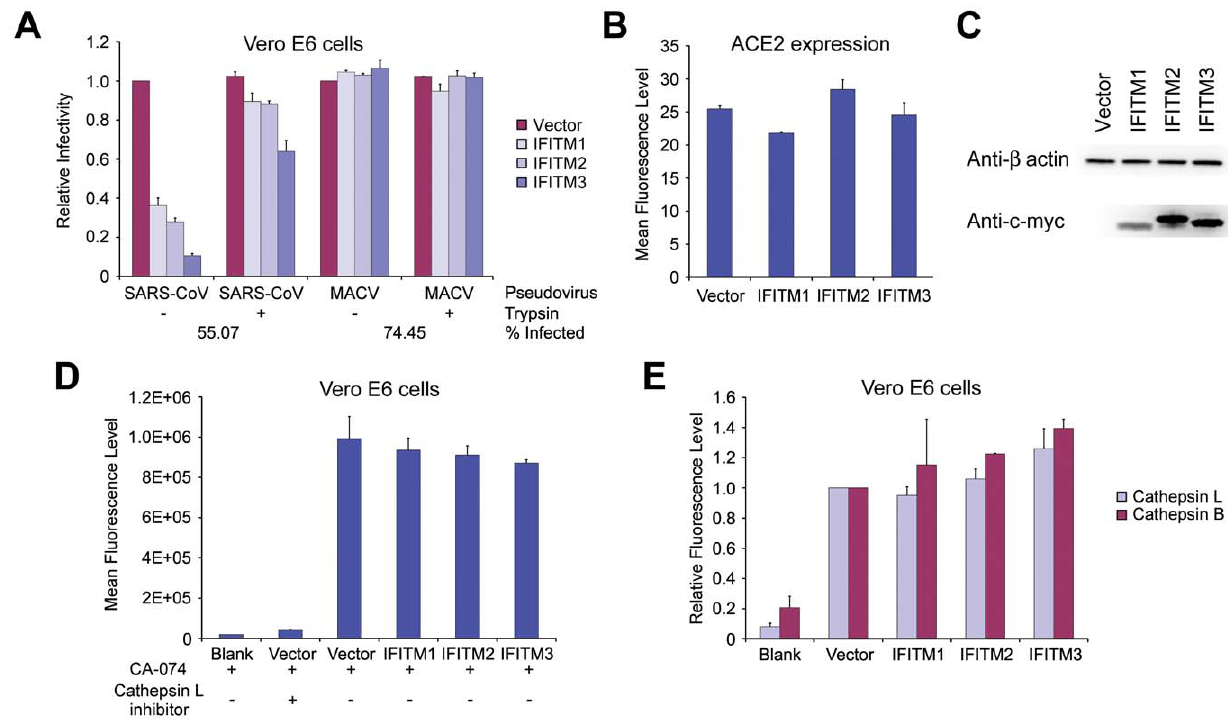
Figure 6. Trypsin treatment bypasses IFITM restriction of entry mediated by SARS-CoV S protein. ( A ) Vero E6 cells transduced to express the indicated c-myc-tagged IFITM proteins or with vector alone were subsequently transduced to express ACE2. Two days later, cells were spin- inoculated at 4 u C with indicated pseudoviruses and then treated with 5 m g/ml trypsin or phosphate-buffered saline (PBS) at 37 u C for 13 minutes. Infected cells were maintained in growth medium and pseudovirus infection was determined by flow cytometry two days later. Relative infectivity was shown as the percentage of GFP-positive cells, normalized to that of cells transduced with vector alone and treated with PBS. Differences in SARS-CoV pseudovirus entry between trypsin-treated and untreated cells are significant ( P , 0.5) for all IFITM-expressing cells. ( B ) In parallel, ACE2 cell- surface expression was measured on aliquots of Vero E6 cells used in (A). Vero E6 cells were labeled with Alexa 488-conjugated S-protein RBD of SARS-CoV and analyzed by flow cytometry. ( C ) IFITM protein expression in ACE2-expressing Vero E6 cells was measured by western blot with an anti- c-myc antibody (9E10), using aliquots of the same cells assayed in (A). Figs. (A)–(C) are representative of three experiments with similar results. ( D ) Cathepsin L activity in Vero E6 cells transduced with vector alone or stably expressing indicated IFITM proteins was measured fluorometrically and is shown as mean fluorescence. Cells treated with a cathepsin L inhibitor were used as a control. No statistically significant differences were observed between vector-transduced and IFITM-expressing cells. ( E ) Vero E6 cells transduced with vector alone or stably expressing the indicated IFITM proteins were labeled with MR-(FR) 2 or with MR-(RR) 2 , which bind to the active forms of cathepsin L or B, respectively. Cells were labeled for 1 hour, fixed with formaldehyde, and analyzed by flow cytometry. In vector-transduced cells, mean fluorescence for MR-(FR) 2 was 1175.7 and for MR-(RR) 2 was 454.7. The modest enhancement for cathepsin B activity in IFITM2 and 3 expressing cells is significant ( P , 0.05), whereas no significant differences were observed in cathepsin L activity. Experiments in (D) and (E) are representative of two experiments with similar